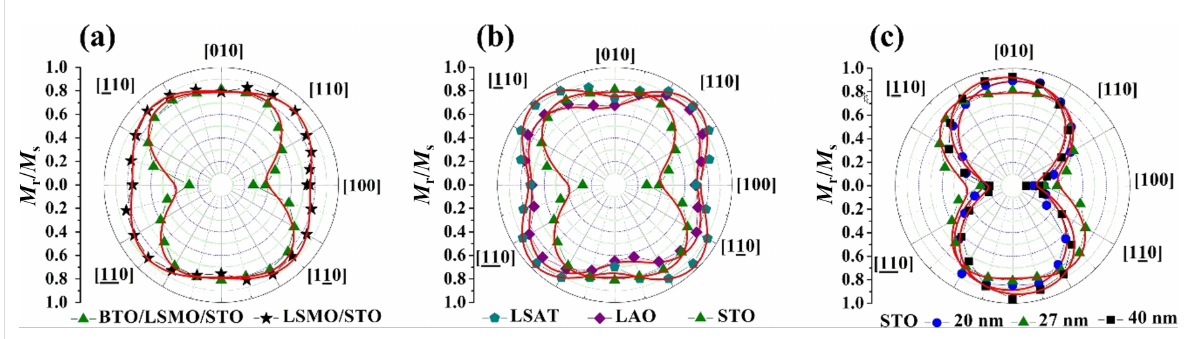
Figure 4: Polar plots of the normalized remnant magnetization, at 300 K, for (a) LSMO (27 nm) layer (black stars) and BTO/LSMO bilayer (green tri- angles) grown on STO; (b) BTO/LSMO bilayers grown on STO (green triangles), LAO (purple diamonds), and LSAT (dark cyan pentagons) sub- strates; (c) BTO/ LSMO bilayer with t LSMO = 20 nm (blue circles), 27 nm (green triangles) and 40 nm (black squares). Continuous red lines corre- spond to numerical